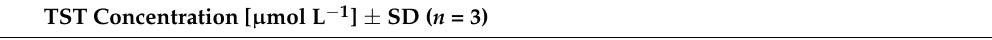
Table 2. The outcomes of TST determination in reference material of human urine and wastewater purified in a sewage treatment plant.